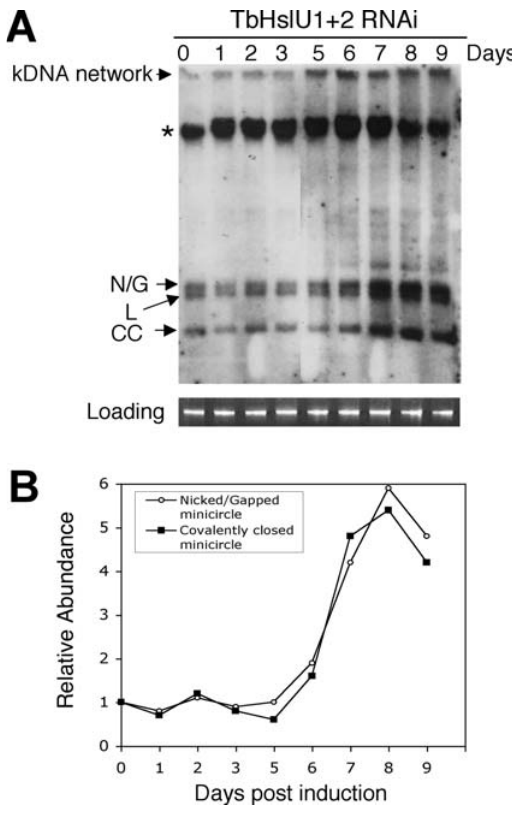
Figure 5. Effect of TbHslU1 + 2 double RNAi on free minicircle replication intermediates. ( A ). Total DNA was fractionated on an agarose/ethidium gel and a Southern blot was probed for minicircles. N/G, nicked/gapped minicircles; L, linearized minicircles; CC, covalently- closed minicircles, *, nonspecific hybridization to nuclear DNA. The nicked/gapped minicircles form a doublet with the lower component possibly linearized minicircles. Since it is present prior to RNAi induction (day 0), it is likely unrelated to RNAi. ( B ). Quantitation (by Phosphor- imager) of bands from A . The nicked/gapped species includes both components of the